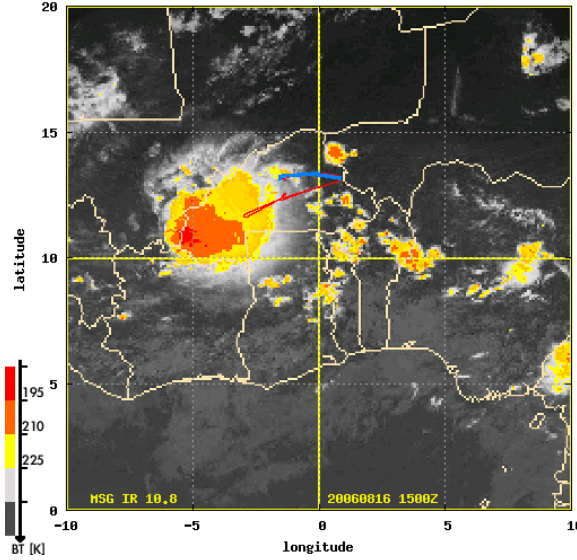
Fig. 1. Flight track on 16 August 2006. The part corresponding with the AMMA intercomparison exercise is highlighted in blue and was from 15:00 to 15:50 whilst the Meteosat infrared image is from 15:00 UTC.